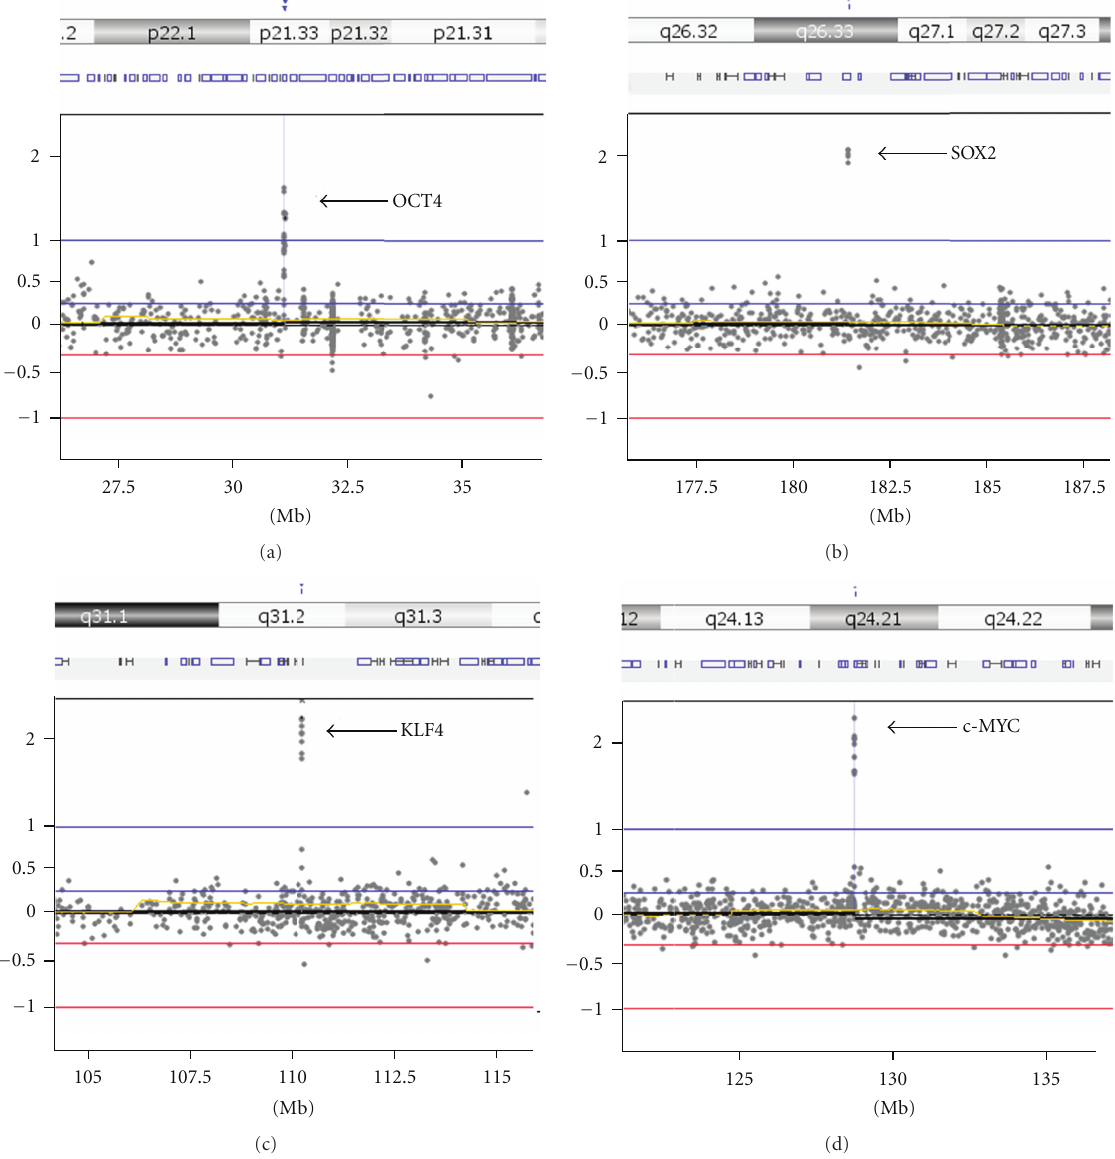
Figure 2: iPSC lines are typically derived by transforming fibroblast cells with retroviral vectors containing OCT4 , SOX2 , KLF4, and c-MYC . These reprogramming genes provide excellent positive controls for the microarray as multiple duplications for each transgene should be observed. The updated 135 K StemArray can detect multiple copy integrations of the iPSC transforming factors (a) OCT4 , (b) SOX2 , (c) KLF4 , and (d) c-MYC